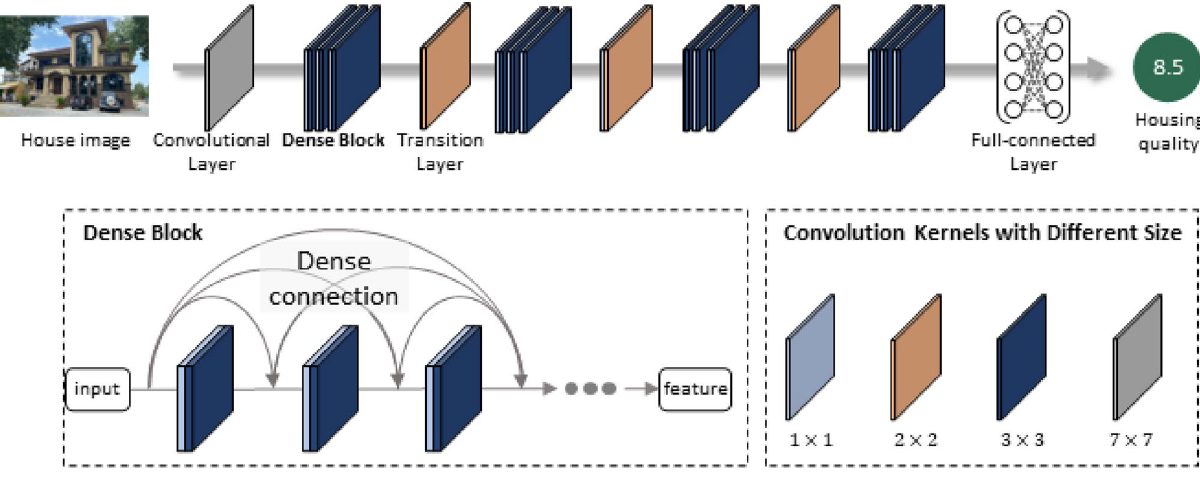
Figure 8. The architecture of